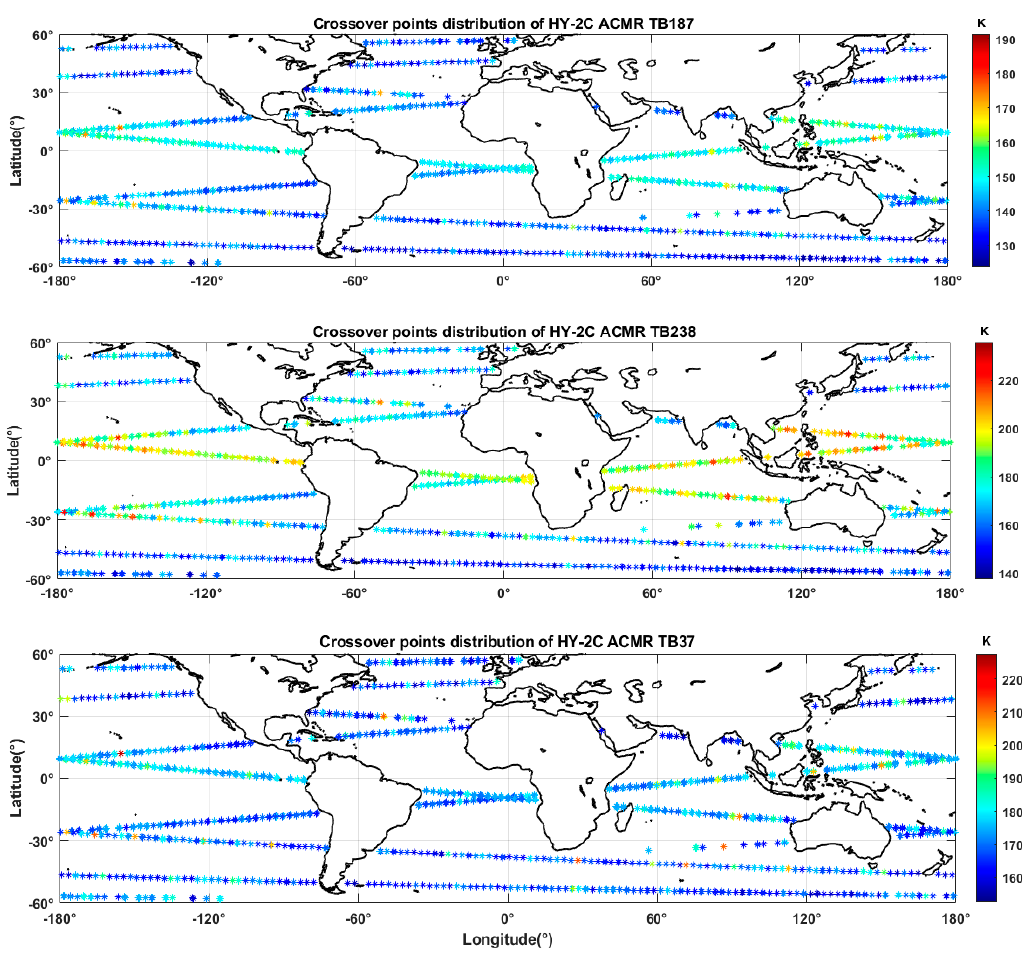
Figure 1. Crossover points spatial distribution of TB 18.7 in K ( top panel), TB 23.8 ( middle panel) and TB 37 ( bottom panel).